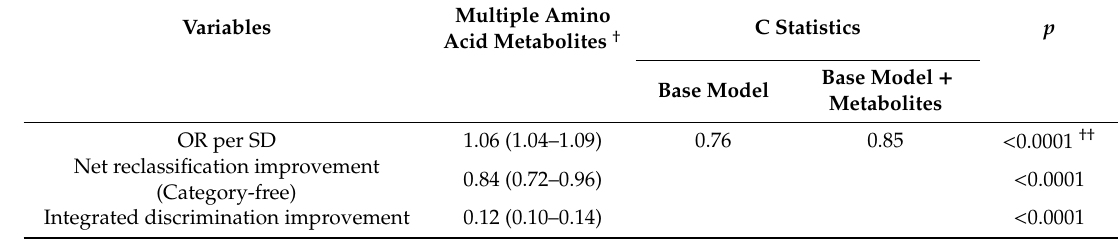
Table 6. Multiple amino acid metabolites and prediction of CKD incidence.